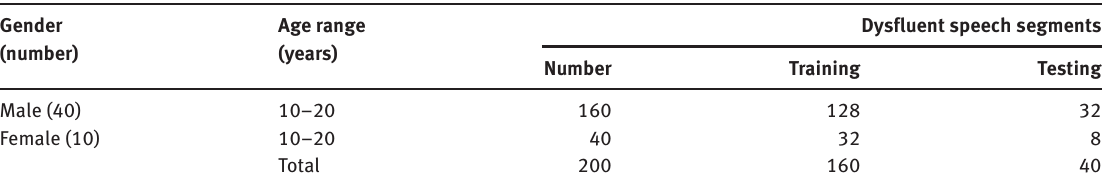
Table 2: Age, Gender and Dysfluent Segments selected from Subset of UCLASS Database.